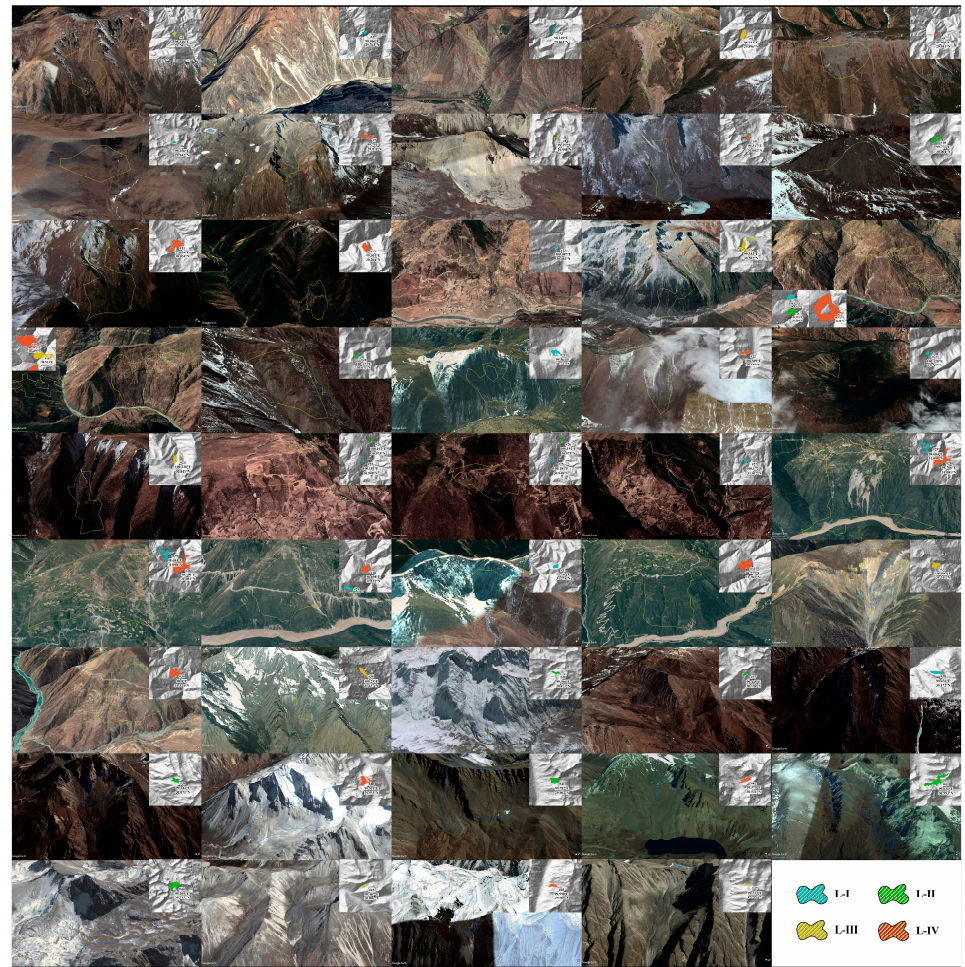
Figure 15. Optical images of identified landslides. The yellow line and blue lines represent landslides identified by the negative and positive deformation maps, respectively. The legend in the lower-right corner indicates the grade of landslides.